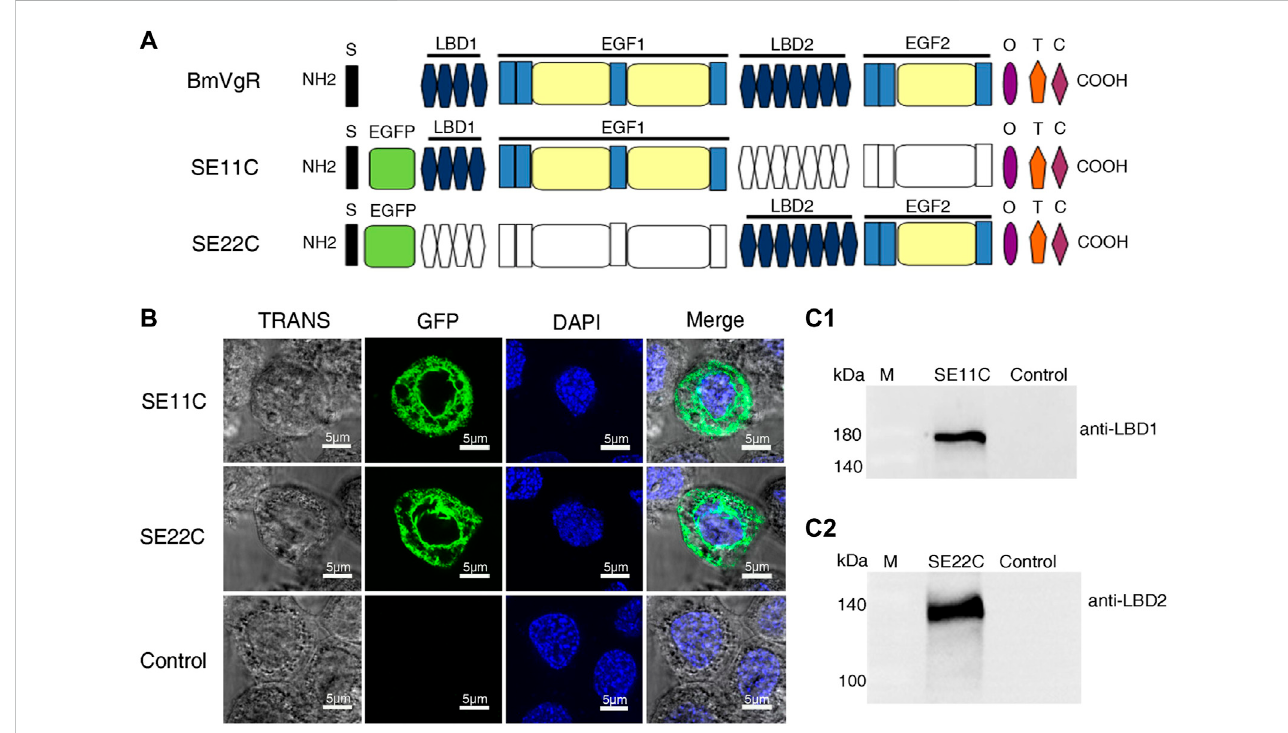
FIGURE 4 Structure and localization of SE11C and SE22C. (A) Structural schematic diagram of BmVgR, SE11C, and SE22C. S, signal peptide; EGFP, enhanced green fl uorescence protein tag; LBD, ligand-binding domain; EGF, epidermal growth factor precursor homology domain; O, O-linked sugar domain; T, transmembrane domain; C, cytoplasmic domain. The colorless box indicates the missing corresponding domains; the color box indicates that it constitutes the corresponding domains. (B) Detection of SE11C and SE22C in sf9 cells using green fl uorescence under a laser confocal microscope. Sf9 cells over- expressingSE11CandSE22C,respectively;Control:sf9cells.TRANSimagesshowthebright fi eldimageofcells;GFPimagesindicatethelocalizationofSE11C and SE22C (Green); DAPI images show the nuclear counterstain (Blue); The Merge images combine the images of TRANS, GFP, and DAPI. (C) Expression of SE11C (C1) and SE22C (C2) in sf9 cells detected by western blotting. Samples were detected using western blotting with anti-LBD1 or anti-LBD2 rabbit antibody (1:10,000) and HRP-conjugated goat anti-rabbit IgG (H + L) antibody